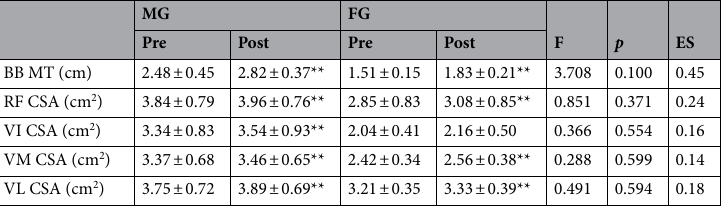
Table 2. ANCOVA output for sex-differences in absolute pre-to-post changes of muscle size. MG males group, FG females group, MT thickness, CSA cross-section area, BB biceps brachii, RF rectus femoris, VI vastus intermedius, VM vastus medialis, VL vastus lateralis. **Significantly greater than pre-training p < 0.01.